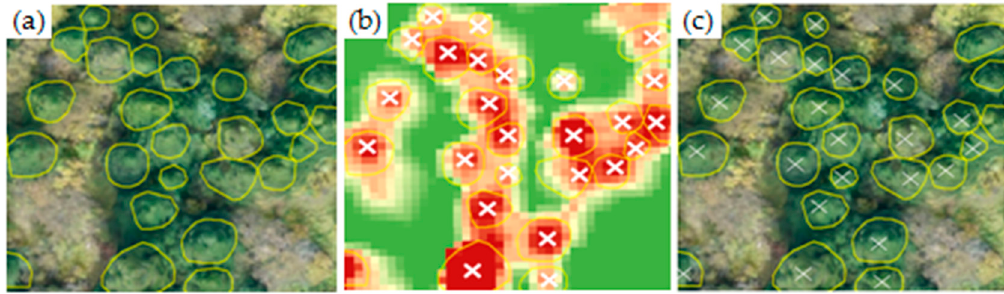
Figure 6. Segmentation of individual tree canopies and extraction of individual tree heights.